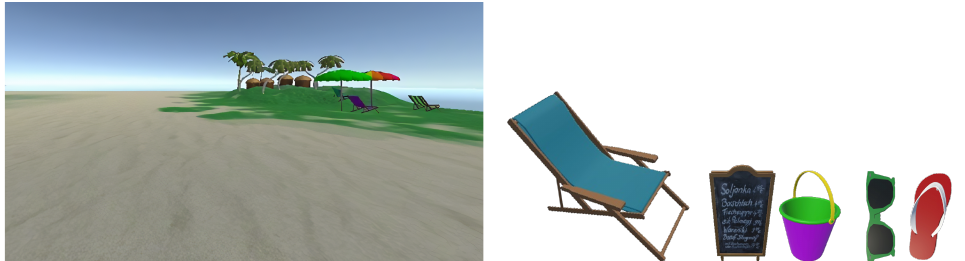
Figure 2. The created 3D beach environment with exemplary corresponding objects, one from the large size, two from the medium size, and two from the small size groups, chosen based on prestudy survey